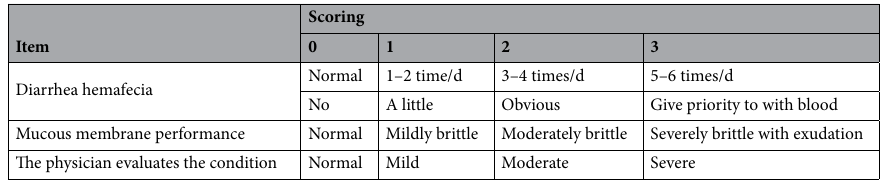
Table 3. Sutherland disease activity index. A total score below 2 was considered symptom relief; between 3 and 5 was mild activity; 6–10 was moderate activity; 11–12 was severe activity.